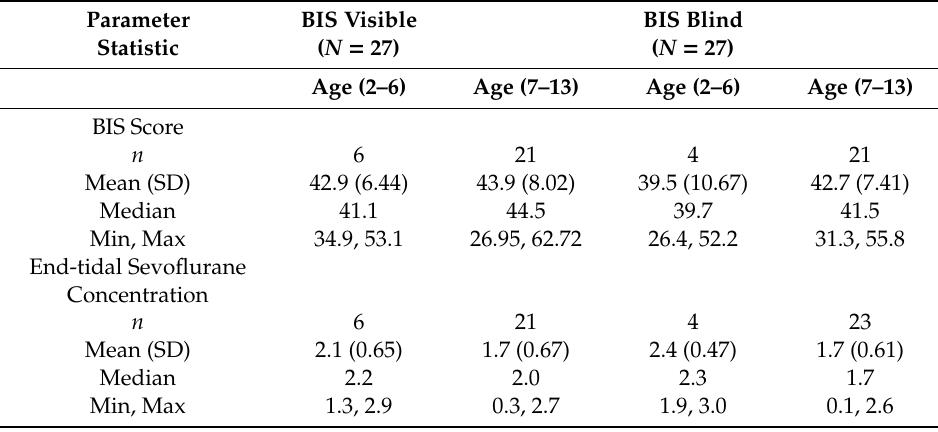
Table 5. BIS Score and end-tidal sevoflurane concentration by age